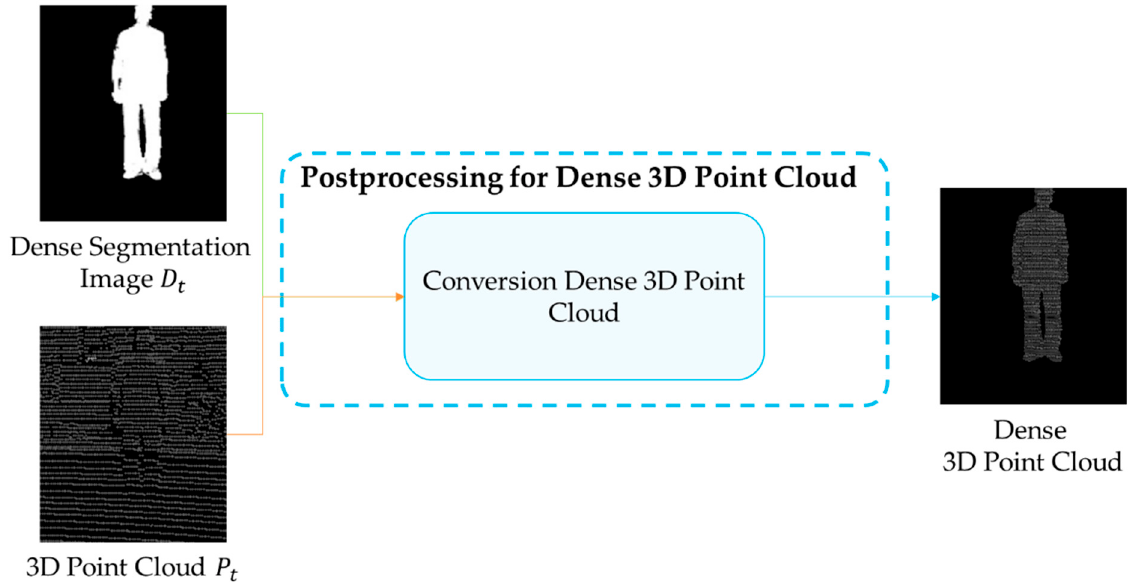
Figure 5. Postprocessing to construct a dense 3D point cloud by utilizing the collected 3D point cloud and dense segmented image.